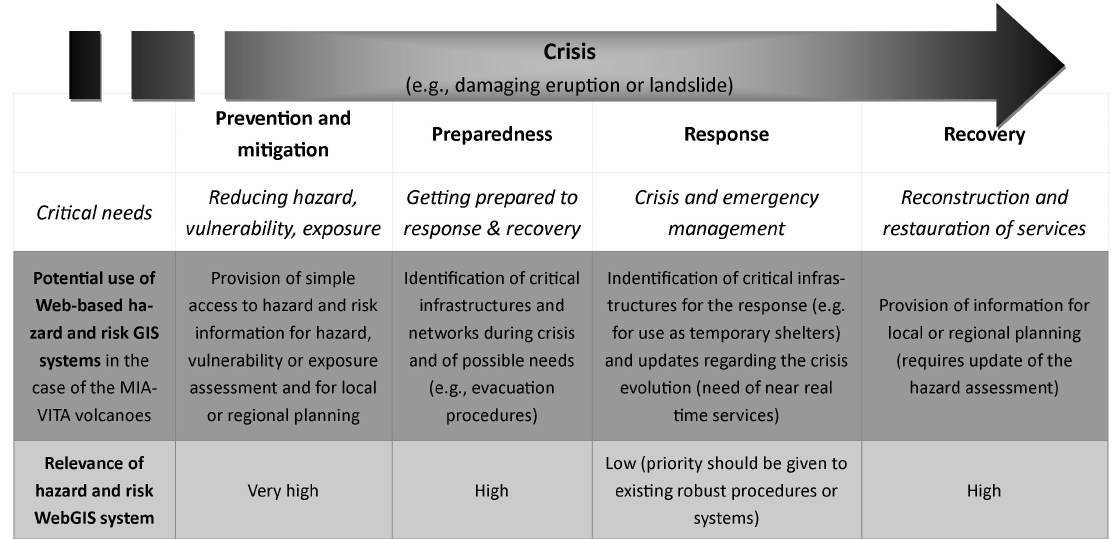
Figure 1. Disaster management cycle and the potential use of a Web-based GIS information system throughout the different phases of the cycle. In the case of the MIAVITA volcanoes (Mt Cameroon in Cameroon; Fogo in Cape Verde; Merapi in Indonesia and Kanlaon in the Philippines), it was agreed that such a system would be most relevant in support of the prevention and mitigation phases (long-term anticipation of a potential crisis). However, provided information on critical infrastructures and their utility during the crisis, response and recovery phases is made available (e.g. potential for a recreational area to serve for sheltering displaced people). Therefore, the relevance of the system for preparedness (shorter-term anticipation of the crisis), the response and recovery has also been considered as high. to assess the threats induced by volcanic processes and